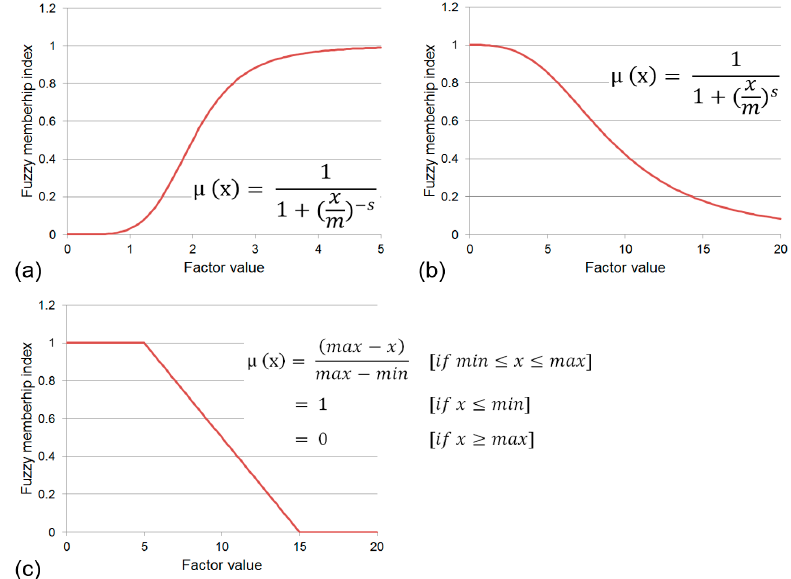
Figure 3. Types and forms of fuzzy membership functions used in this study: ( a ) fuzzy large (monotonically increasing function); ( b ) fuzzy small (monotonically decreasing function); and ( c ) fuzzy linear decreasing function ( x : factor value, μ : fuzzy membership index, m : midpoint, s : spread, min: minimum factor value, max: maximum factor value).